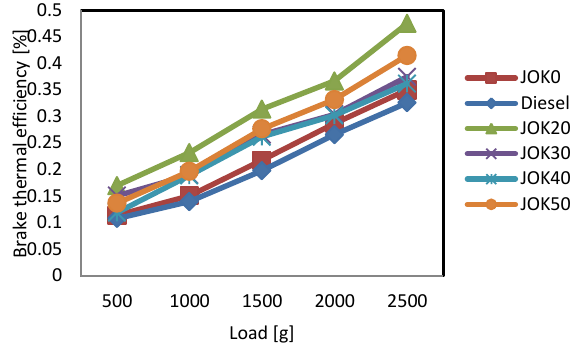
Fig. 6. Variation of BTE for JOK blends with increase in